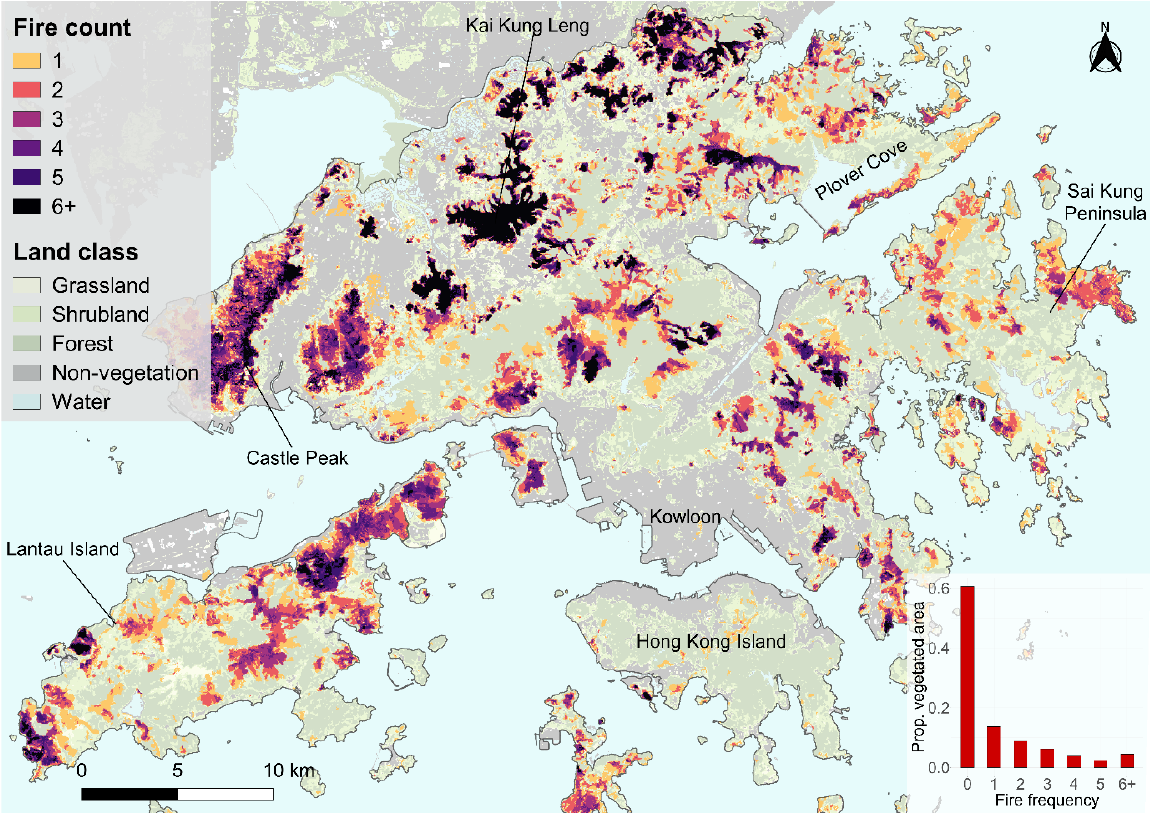
Figure 9. Frequency of fires over different regions of Hong Kong (22°1 6′8″ N, 113°5 7′6″ E). Pixels were coloured according to the number of times it burnt over the 34-year study period (1987–2020). The proportions of vegetated area being burnt 0–6+ times were tallied and plotted on the bottom right panel. The background is a 2013–2014 land classification map derived from Landsat data (Chan et al. unpublished manuscript).